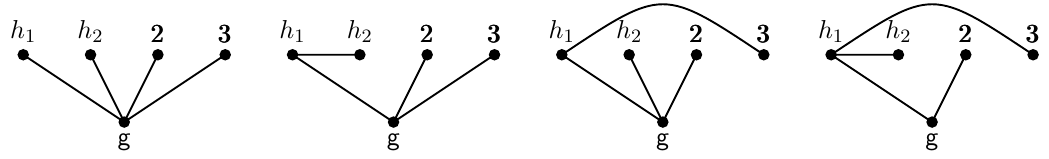
Figure 4 . The four trees that contribute to (cid:26)(cid:26)(cid:26) of (10.14) when b 2 = d 2 and b 3 = d 3 . Before moving on, we go back to our example (10.14). Among the 4! = 24 increasing trees of the (cid:12)(cid:12)(cid:12) given in (10.16), only the four given in (cid:12)gure 4 can possibly contribute. It is now clear that this C ( (cid:26)(cid:26)(cid:26) ) 6 = 0 only if b